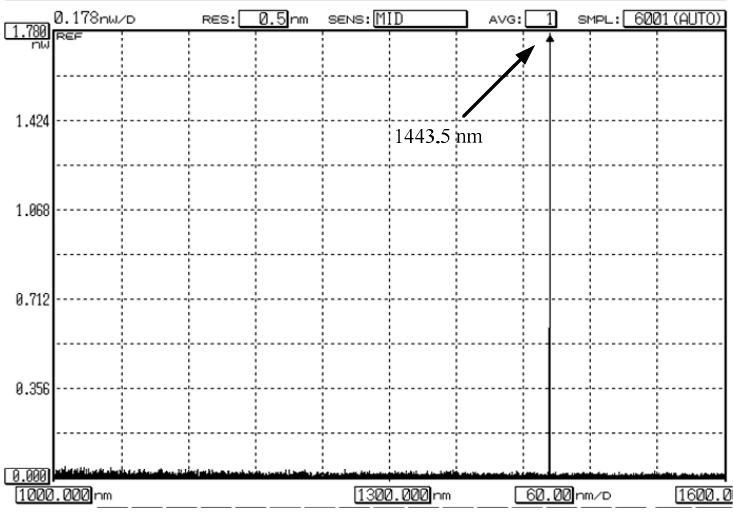
Figure 3. The optical spectrum of the Nd:YAG SCF laser.